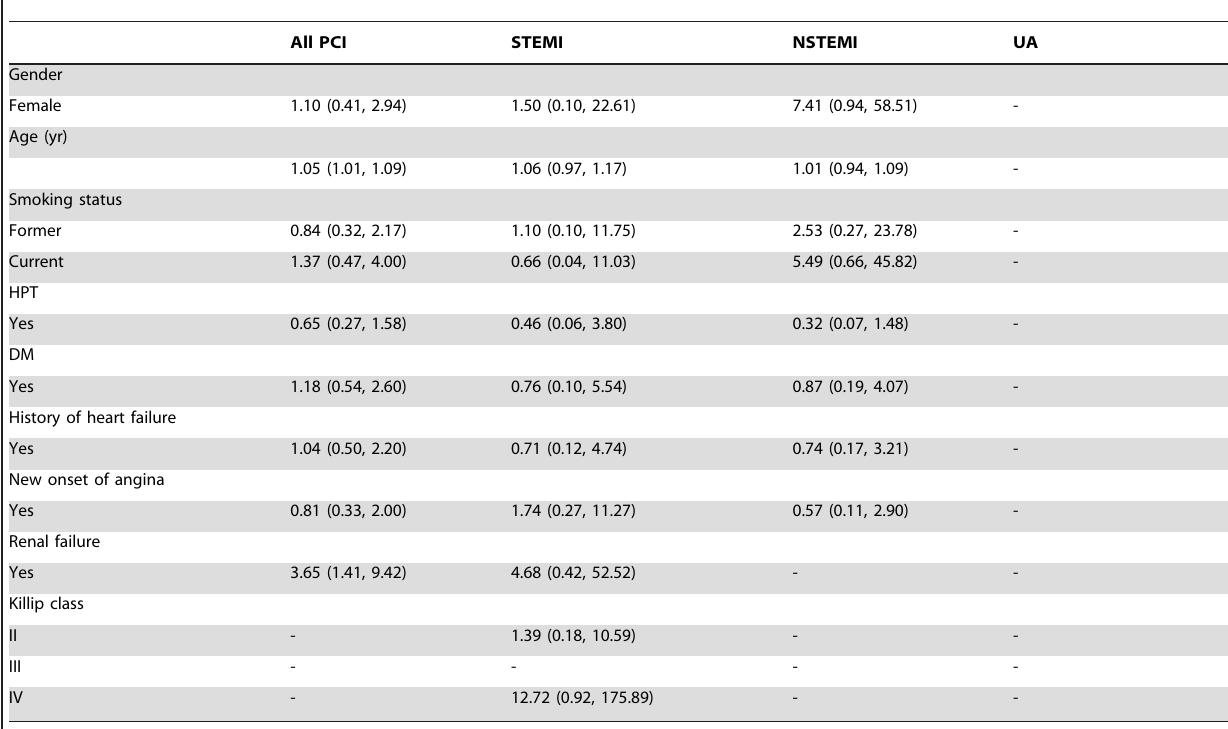
Table 7. Risk of mortality at 30 days for total population.